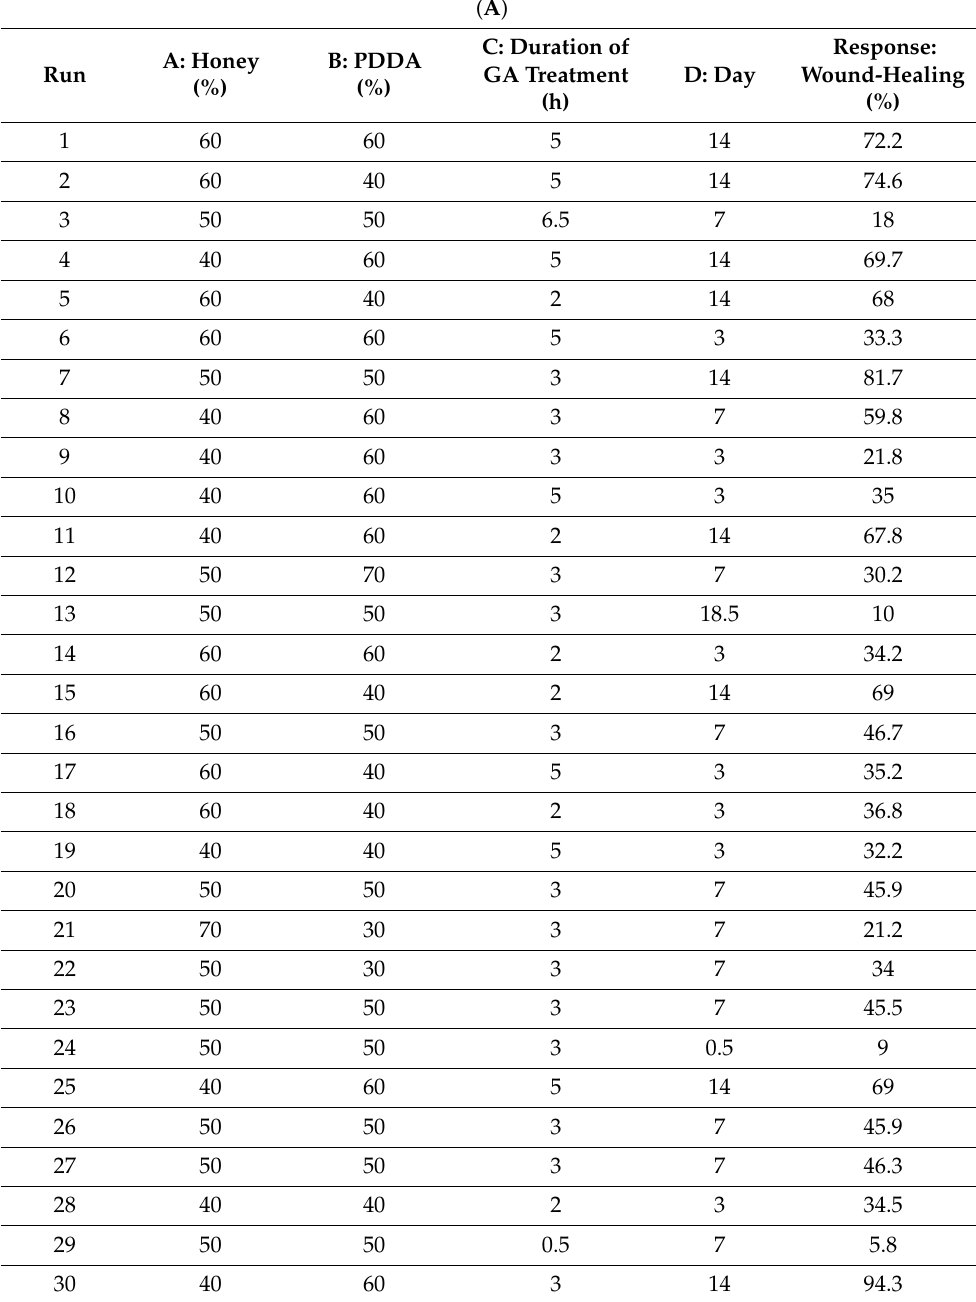
Table 2. ( A ) An experimental design used to evaluate wound-healing properties (%), ( B ) ANOVA analysis (%) used in this study, and ( C ) optimum values for wound-healing (%) regarding the different parameters used in this